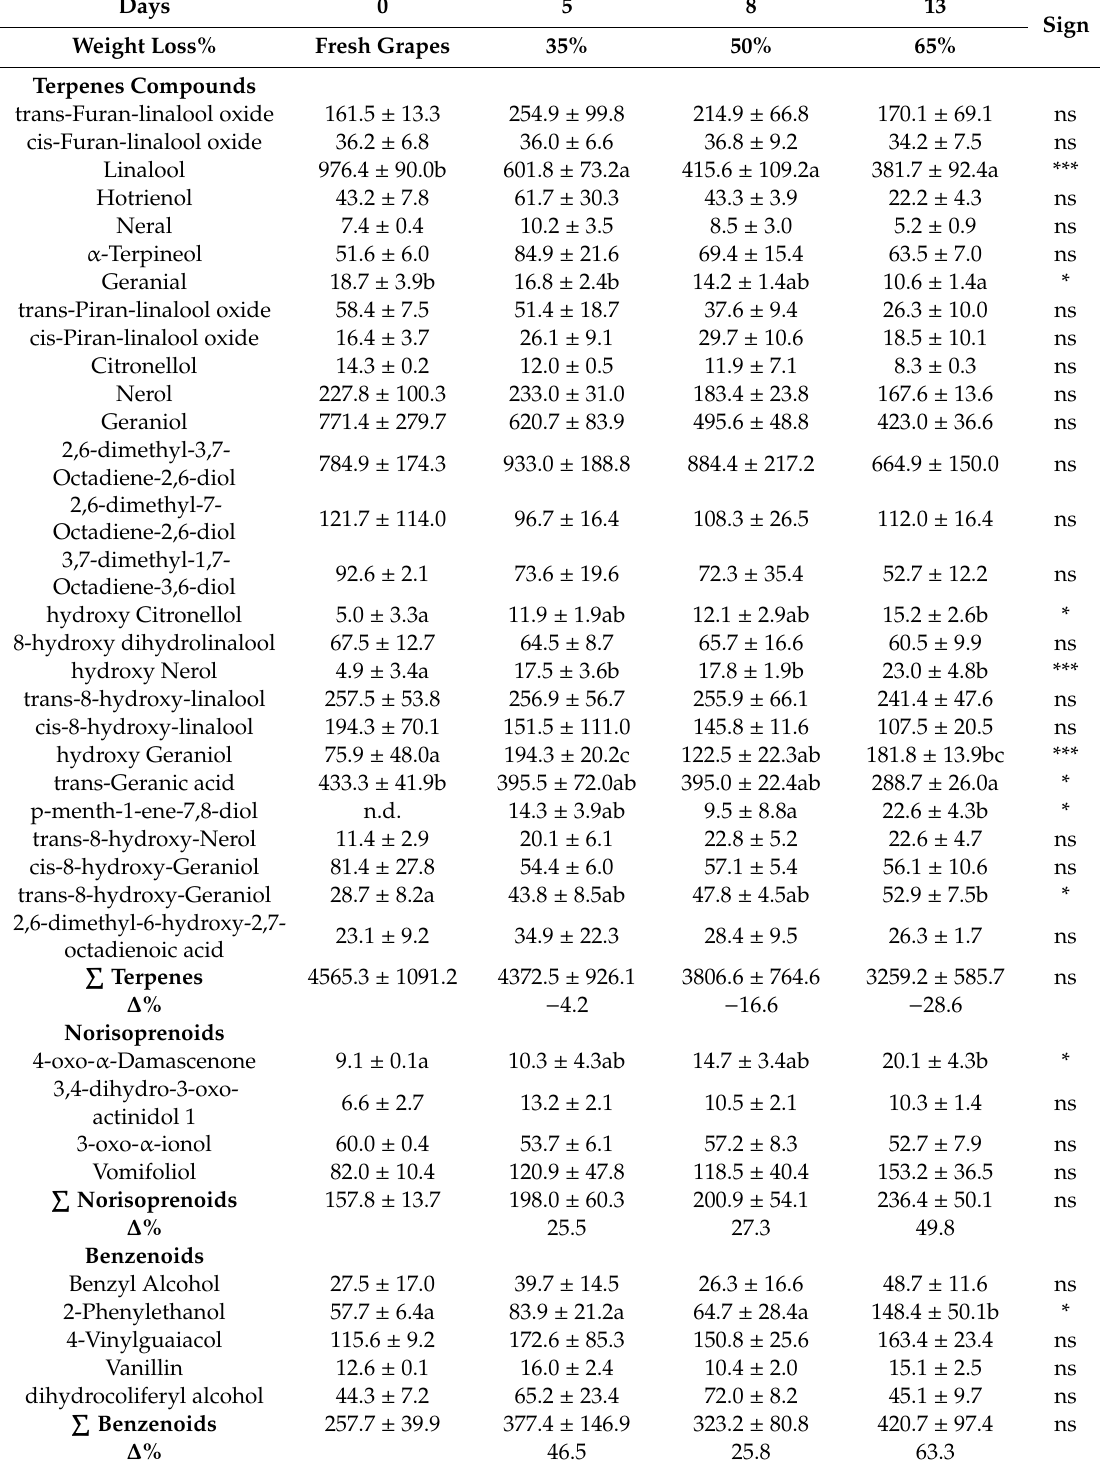
Table 4. Evolution of glycosylated volatile compounds of Muscat Alexandria grapes during dehydration ( µ g / 100